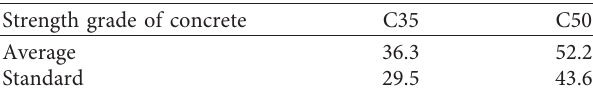
Table 3: Mechanical properties of concrete